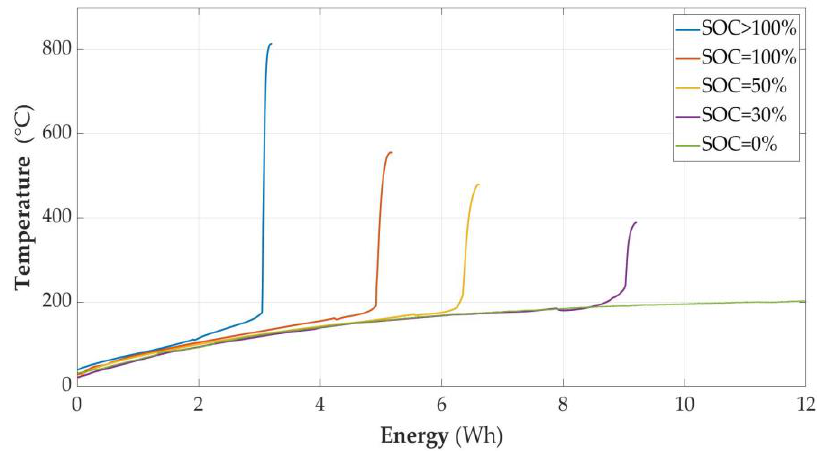
Figure 12. Comparison of flammability properties of cells with different states of charge as a function of Energy supplied to the cell module.